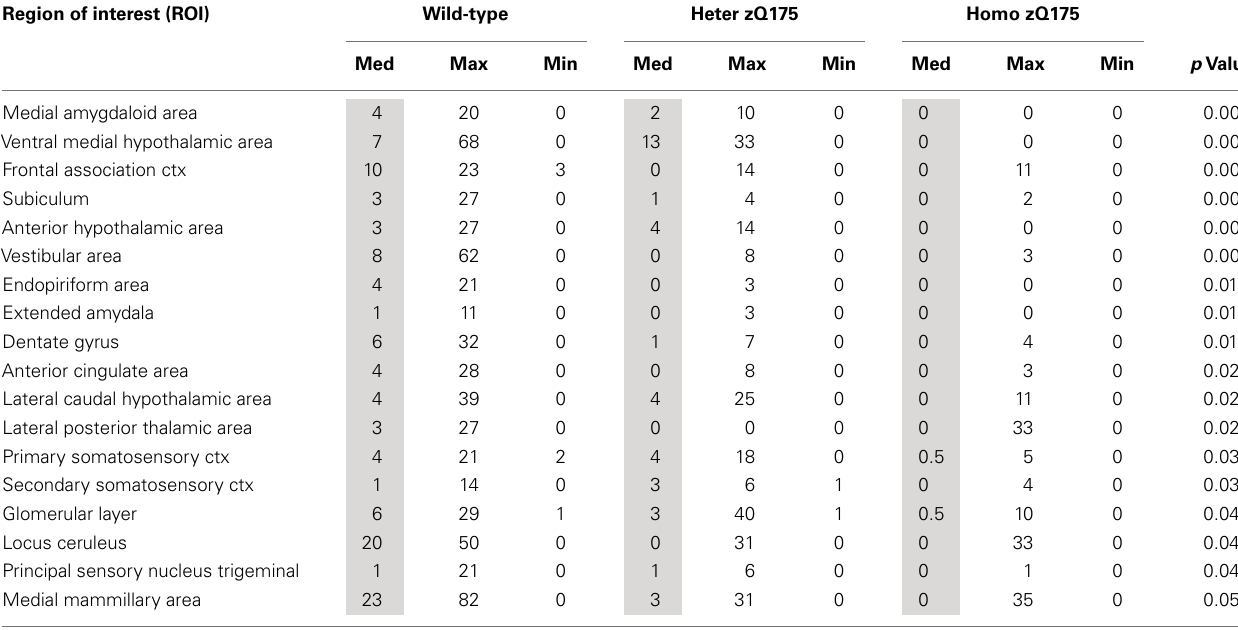
Table 1 |Volume of activation in response to almond odor